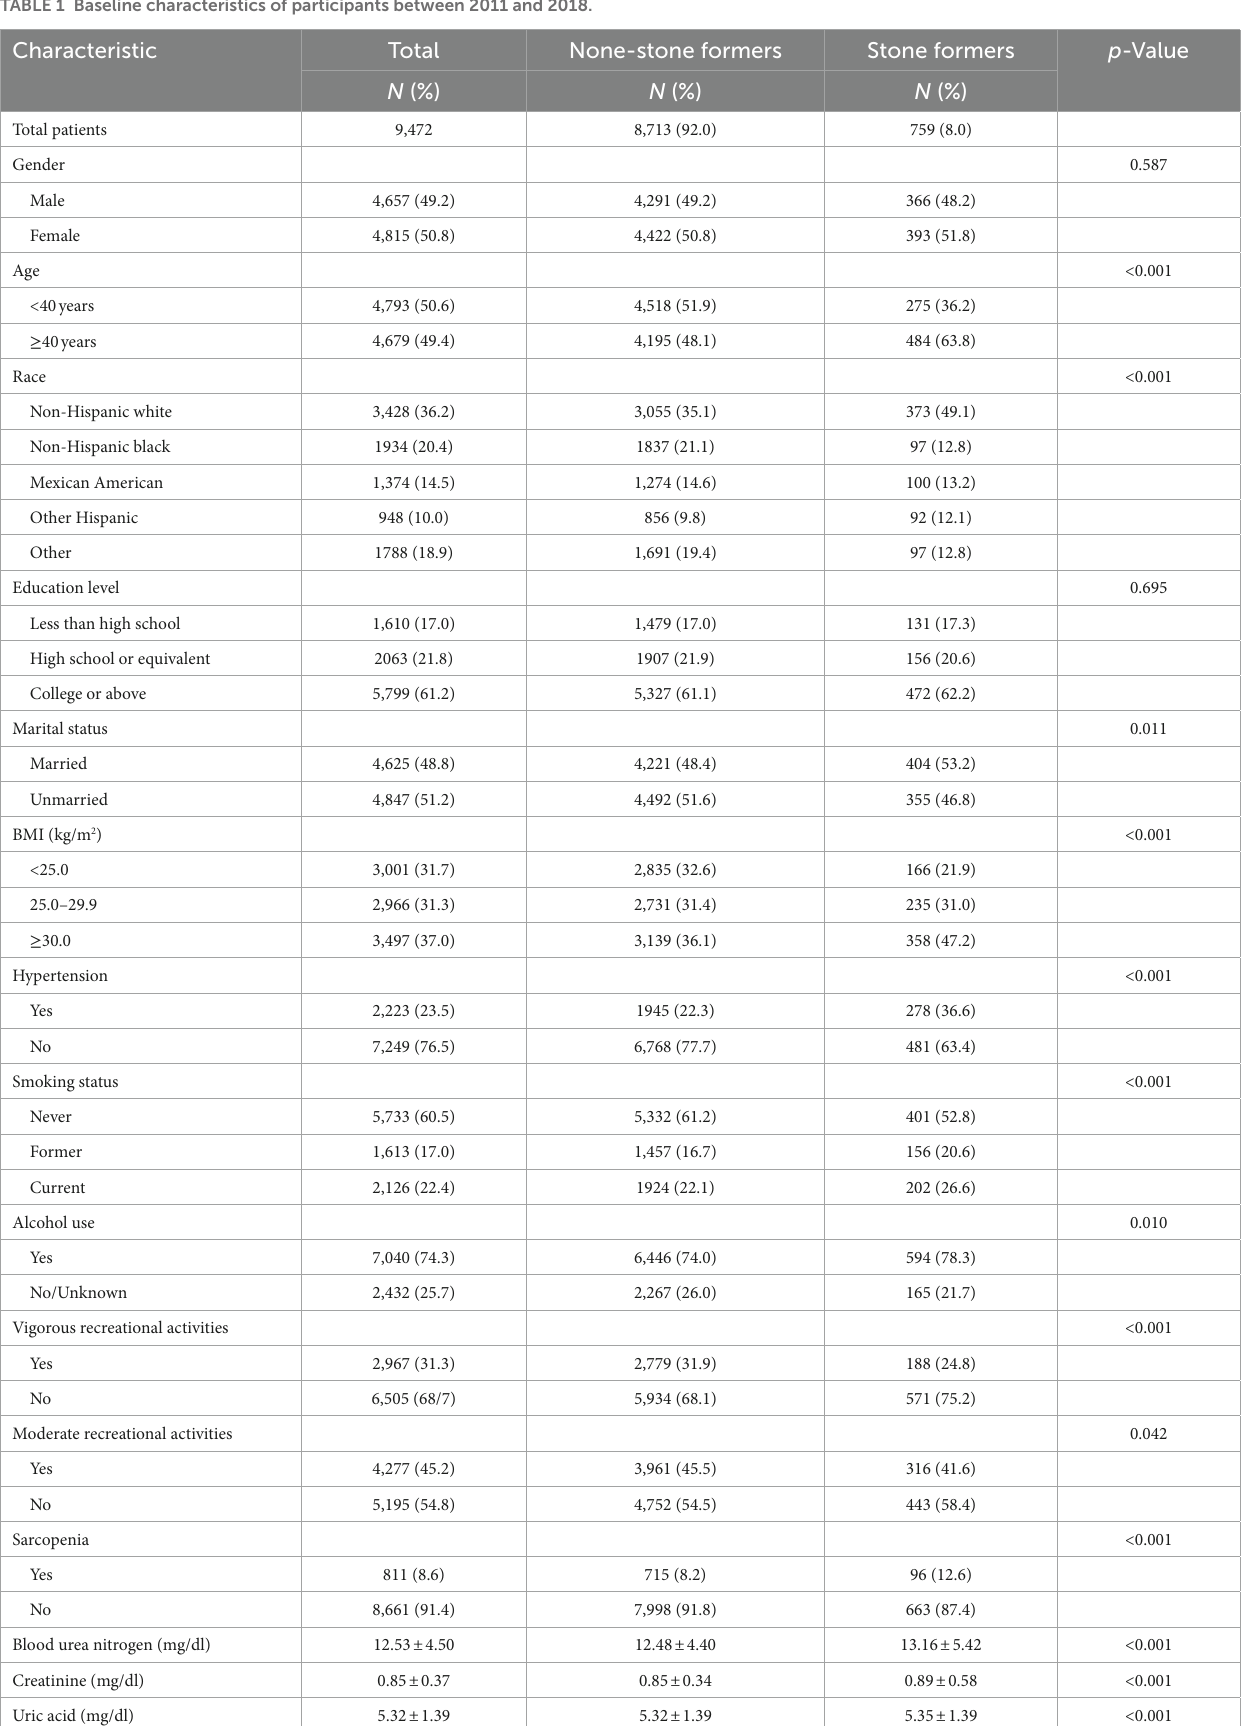
TABLE 1 Baseline characteristics of participants between 2011 and 2018. Characteristic Total None-stone formers Stone